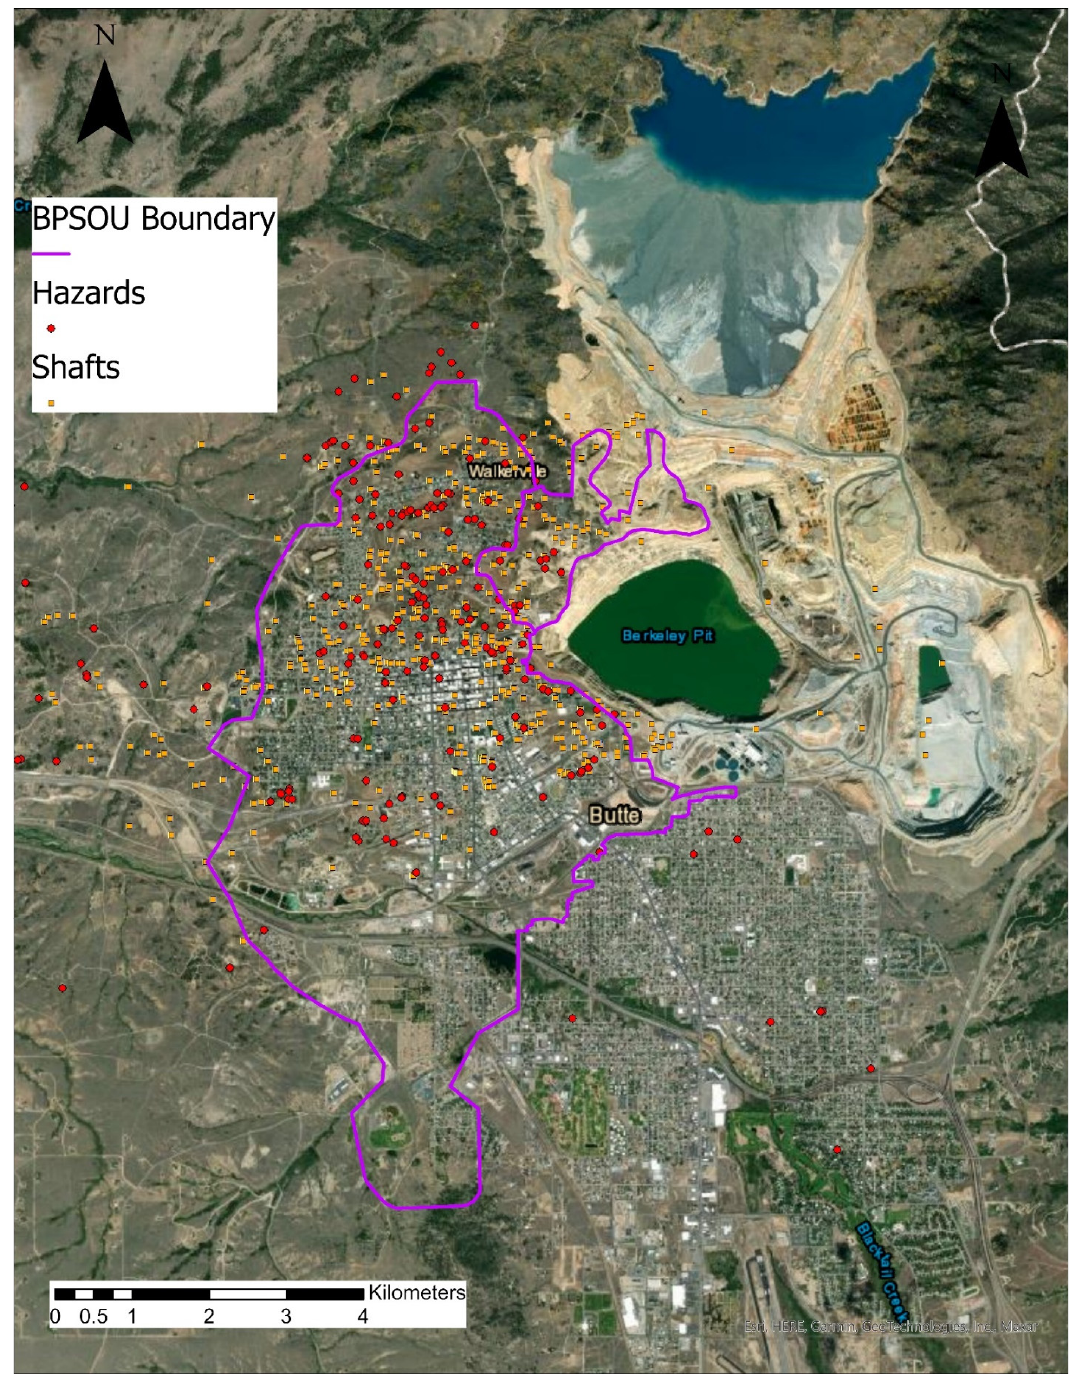
Figure 1. The overlay in this aerial perspective of the study area shows how intense and widespread historic mining activities were throughout the city, affecting virtually every neighborhood in the Uptown (north) area. “Shafts” marked in yellow indicate openings to vertical access to underground workings. “Hazards” marked in red reveal sites containing potentially hazardous mining wastes. Butte Priority Soils Operable Unit (BPSOU), Shafts and Hazards map layers were developed by Butte Silver Bow County and are available for public use. Authors have obtained these layers from Joseph Griffin (jgriffin2@mtech.edu).